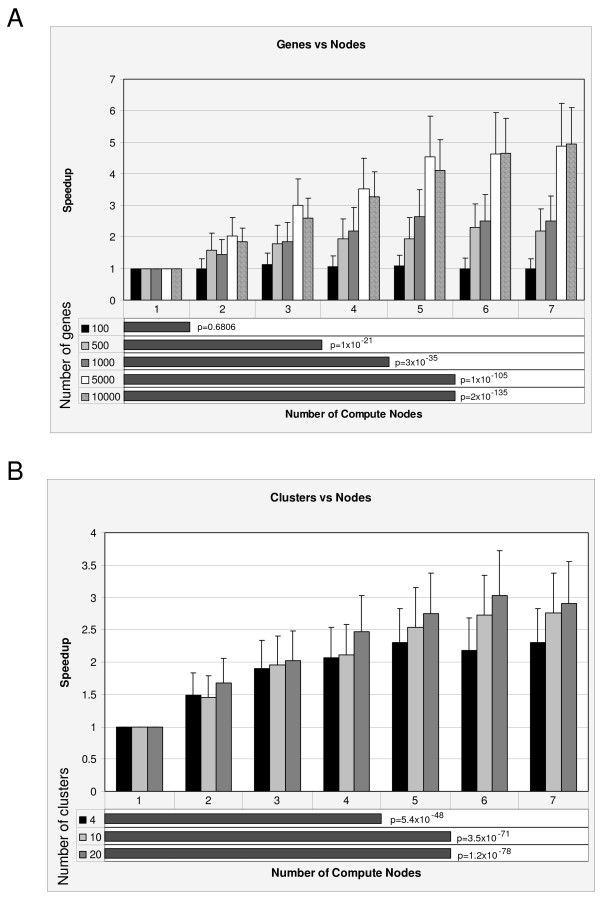
Detected interactions that affect the time of execution using ParaKMeans. The column charts plot the speedup (fold increase) relative to a single node configuration versus the number of compute nodes used in the analysis. The bar graphs at the bottom of each plot illustrate the number of compute nodes where one finds statistically significant increases in speed. The p values presented are for tests of differences between the number of compute nodes for a given number of genes or clusters. A) The effect of the interaction between the number of genes and number of compute nodes on the speed of execution. B) The effect of the interaction between the number of clusters and number of compute nodes on the speed of execution.